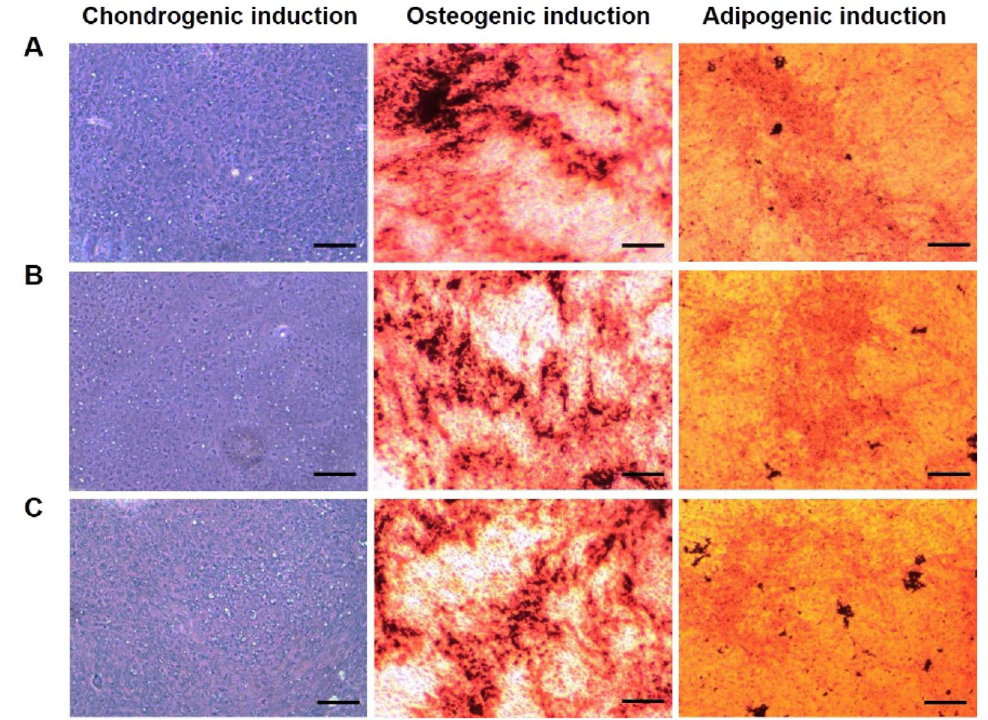
Fig. 4 Determination of the multipotency for hUC-MSCs. A Native MSCs from Wharton’s jelly, B hUC-MSCs, and C BM-MSCs released from the PLGA@PLL scaffold were incubated with a multipotency detection kit and then were induced to differentiate into chondroblasts stained with toluidine blue, osteoblasts stained with Oil red O, and adipoblast stained with alizarin red. Scale bar: 100 μm